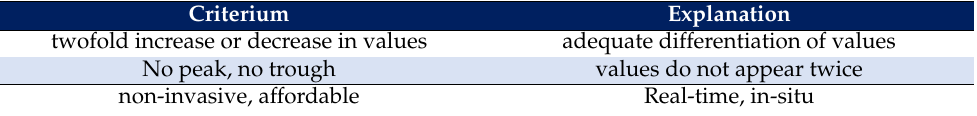
Table 1. Selection criteria for the present study.